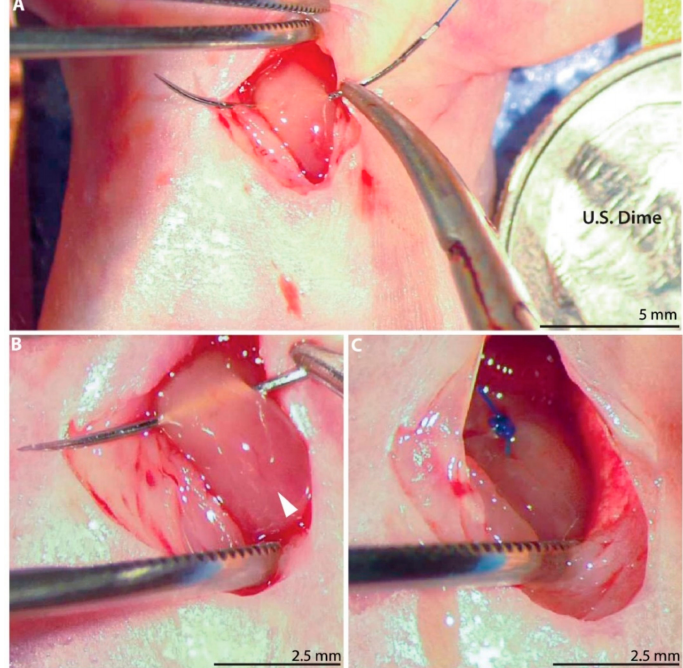
Figure 1. Neonatal rat myocardial infarction model. ( A ) A left anterior thoracotomy is performed to expose the heart. United States dime for scale. ( B ) A 6–0 polypropylene suture is passed below the left anterior descending (LAD) coronary artery (arrow). ( C ) The LAD artery is permanently